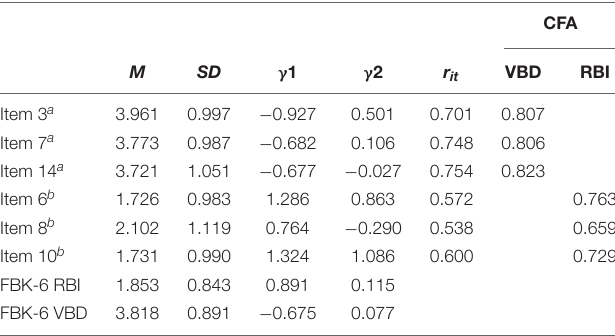
TABLE 3b | Item descriptive statistics and factor loadings in confirmatory factor analysis—ideal body image